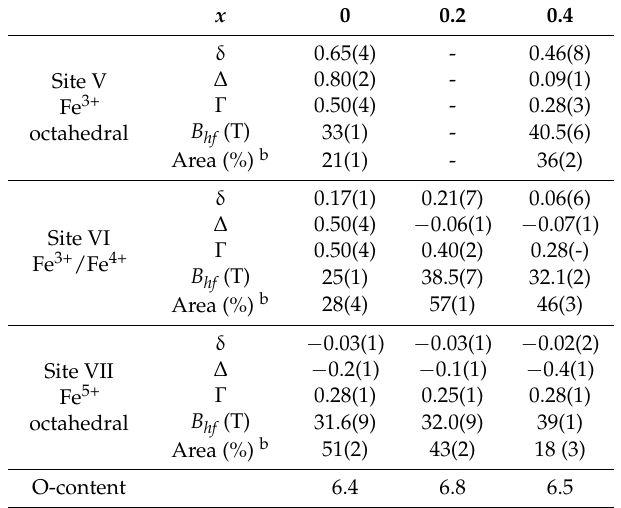
Table 6. Mössbauer spectral parameters at T = 7 K for air-annealed Sr 3 − x Pr x Fe 1.25 Ni 0.75 O 7 − δ phases a